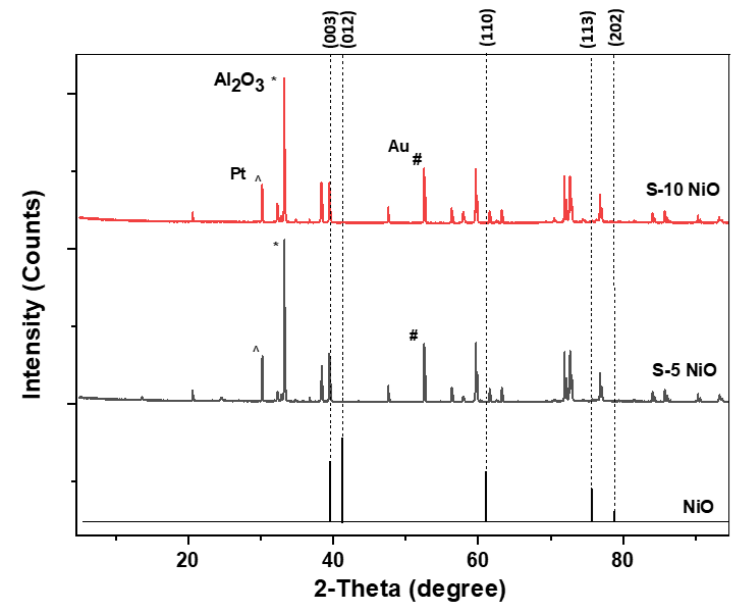
Figure 4. XRD pattern of the deposited S-10 NiO, S-5 NiO, and stick pattern of standard NiO. SEM cross-section images in Figure 5b,d suggest that the film thicknesses are around 5 µ m and 10 µ m for S-5 and S-10 NiO sensors, respectively. The SEM images in Figure 5a,c show that the S-10 NiO film has macro-pores, whilst the S-5 NiO film is more compacted. their grain boundaries. In the S-10 sensor, a more open microstructure was observed, sites for the solid–gas interaction. Furthermore, the presence of macro-pores in the S-10 interact with the inner grains of the sensing element.